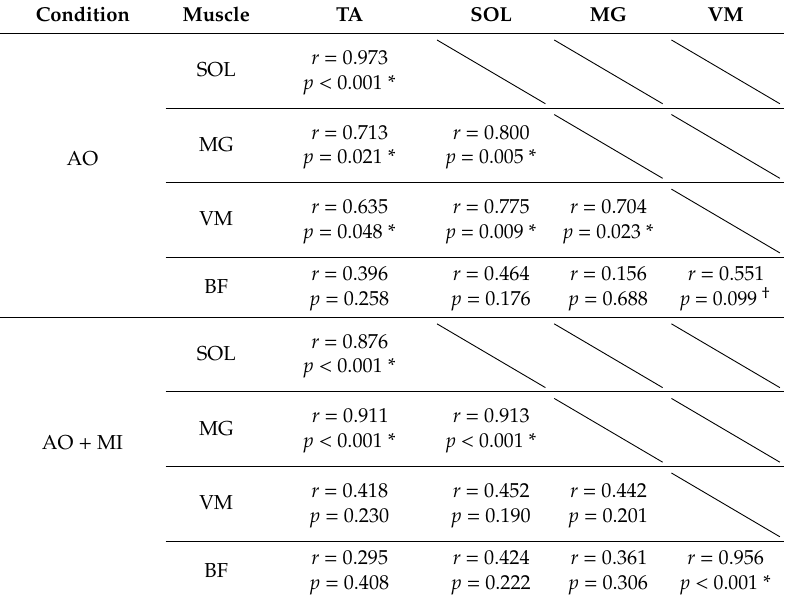
Table 3. Pearson correlation coe ffi cients ( r ) and p values ( p ) of transcutaneous spinal cord stimulation (tSCS)-evoked spinal reflex amplitudes (% of control) between pairs of lower-limb muscles in action observation (AO) and AO with motor imagery (AO + MI)